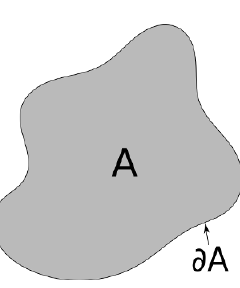
(cid:12) (cid:12) (cid:11) (cid:11) = R Dg (cid:22)(cid:23) (cid:31) ( g (cid:22)(cid:23) ), where (cid:12) (cid:31) (cid:12) g (cid:22)(cid:23) (cid:12) (cid:12) (cid:11) (cid:11) (cid:11) = e (cid:0) i ^ Ht can be also written as = (cid:12) (cid:31) 0 (cid:12) (cid:31) (cid:12) (cid:31) 0 (cid:16) (cid:17) g (cid:22)(cid:23) ; @ is identi(cid:12)ed as an induced Hamiltonian for @g (cid:22)(cid:23)